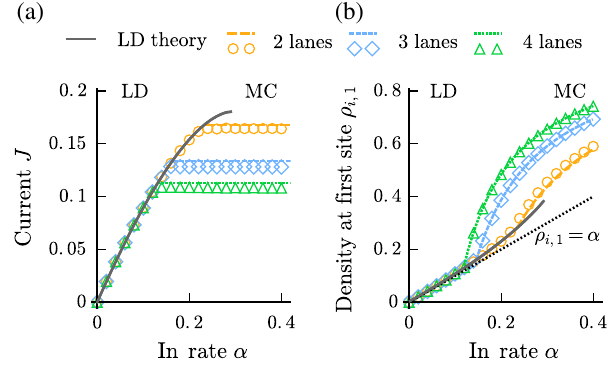
FIG. 14. Comparison between low-density theory (lines) and stochastic simulations (symbols) for the special case δ ¼ 1 = 2 . (a) Current plotted against the in rate α in the LD phase for different numbers of lanes W . For low in rates, the current increases monotonically until it becomes constant at a point that depends on the number of lanes; the respective current corre- sponds to the maximal current of the bulk. Low-density theory agrees with simulation results for the LD phase. The low-density theory is independent of the number of lanes. (b) Density at the first lattice site ρ i; 1 plotted against the in rate α for different numbers of lanes. In the LD phase, the density is dictated by the left boundary and agrees with the low-density theory. After the transition to the maximal-current phase, the density is determined by conservation of the maximal current. Again, the corresponding value for the maximal current depends on the respective number of lanes, which leads to a distinct behavior for different numbers of lanes in the MC